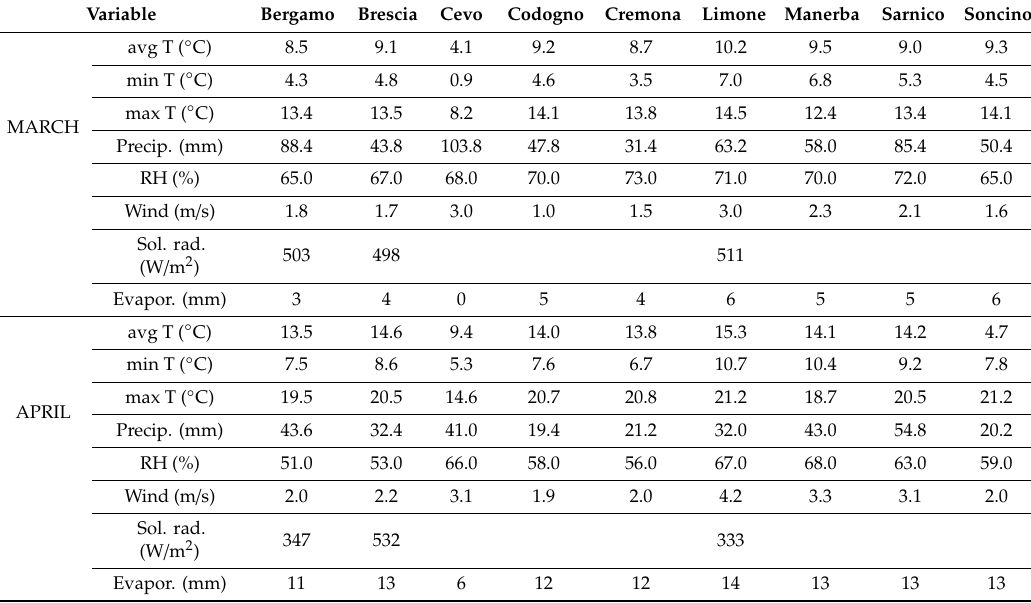
Figure 3. Map of Lombardy, with focus on the outbreak area: The weather stations used for the analysis are highlighted in light blue and the main epidemic outbreaks are highlighted in red. Table 2. Average climatological values for March and April